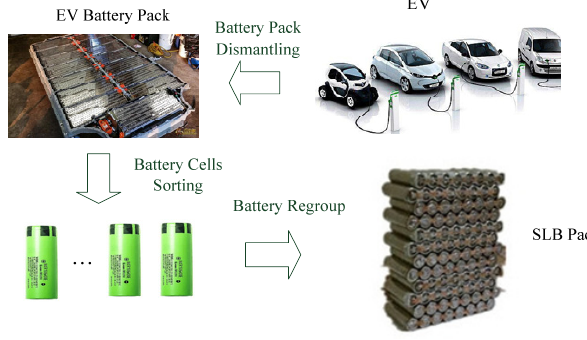
Figure 3. Battery cells are dismantled from electric vehicle (EV) and regrouped to a second life batteries (SLB) pack.